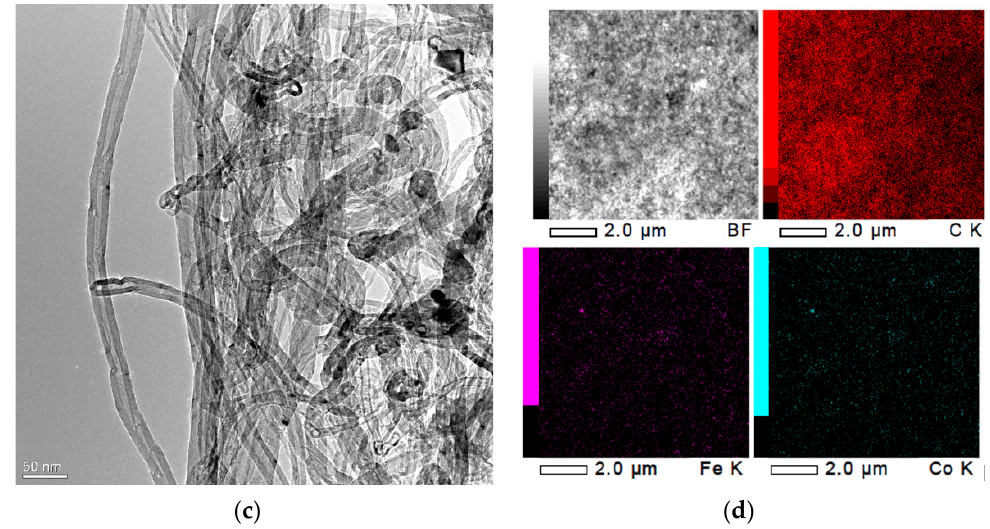
Figure 1. SEM image of hydroxyapatite (HA) composite ceramic with 0.5 wt.% of multi-walled carbon nanotubes (MWCNTs) synthesized at a temperature of 1100 °C in argon atmosphere ( a ) and its energy dispersive X-ray spectroscopy (EDS) spectra ( b ). SEM image of multi-walled carbon nanotubes, ( c ) EDS analysis (SEM image of the cross-section) and elemental mapping of C, Fe, Co ( d ).